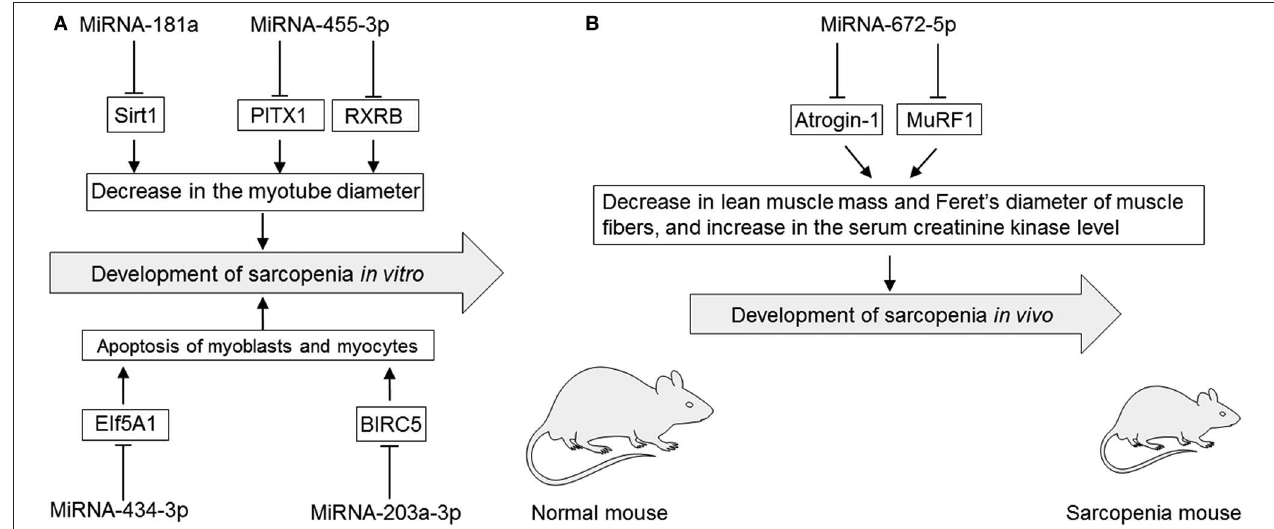
FIGURE 2 | (A) Roles of miRNAs in cultured myotubes, myoblasts, and myocytes in vitro. (B) Roles of miRNAs in rodent sarcopenia models in vivo. EIf5A1, eukaryotic translation initiation factor 5A1; miRNA, microRNA; PITX1, paired-like homeodomain transcription factor 1; RXRB, retinoid X receptor- β ; Sirt1, sirtuin 1; MuRF1, muscle ring-finger